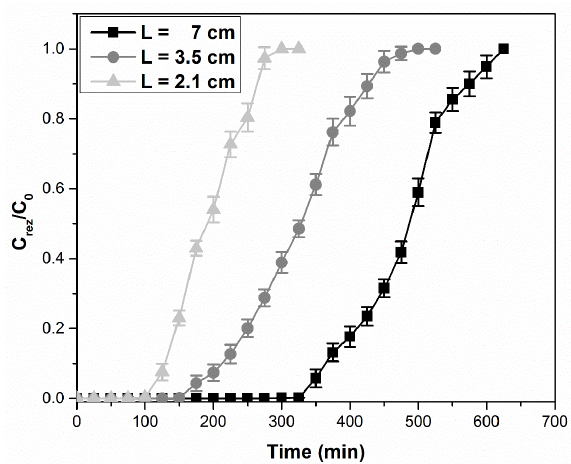
Figure 8. Breakthrough curves for Pd(II) adsorption on a MgSiO 3 -cys fixed-bed column at three fixed- bed bed height columns (BHCs) (T = 298 K, L = 2.1–7.0 cm, Ci = 60 mg L −1 Pd(II), and Q = 7 mL min −1 ). bed height columns (BHCs) (T = 298 K, L = 2.1–7.0 cm, Ci = 60 mg L